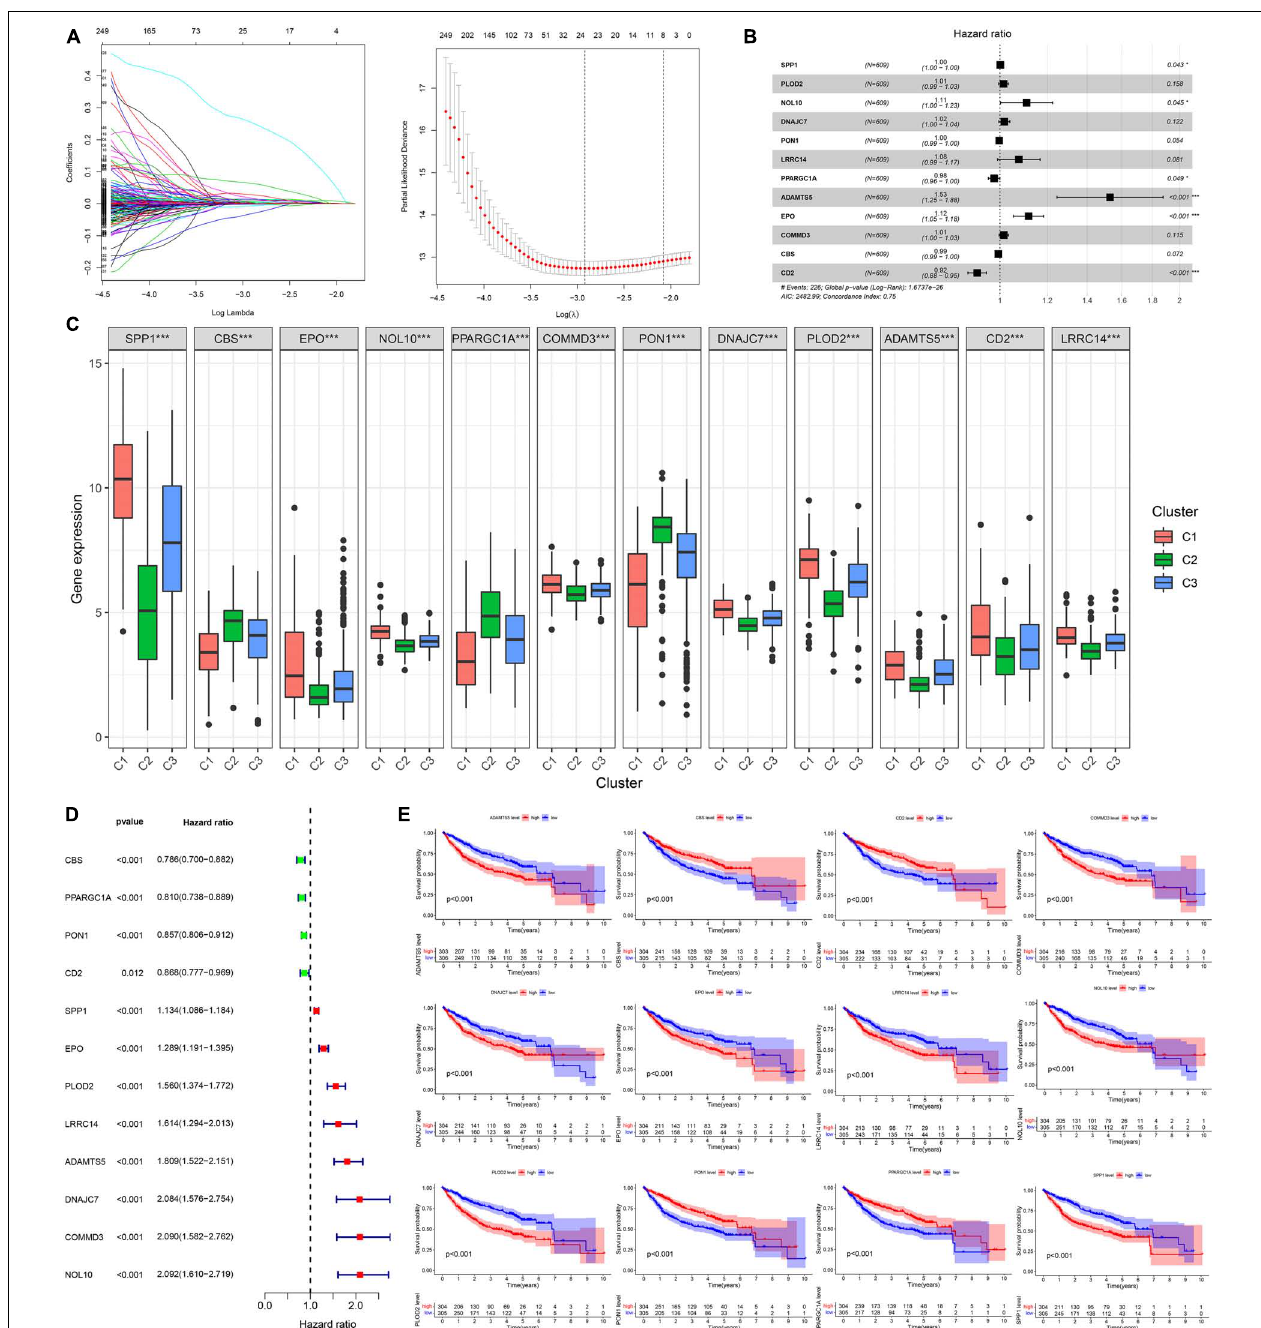
FIGURE 2 | Building process of the prognostic signature in the training cohort. (A,B) LASSO and multivariate Cox regression analysis; * p < 0.05. (C) The boxplot of 12 genes in different subtypes; *** p < 0.001. (D) The forest plot of univariate Cox analysis. (E) The Kaplan–Meier survival analysis.